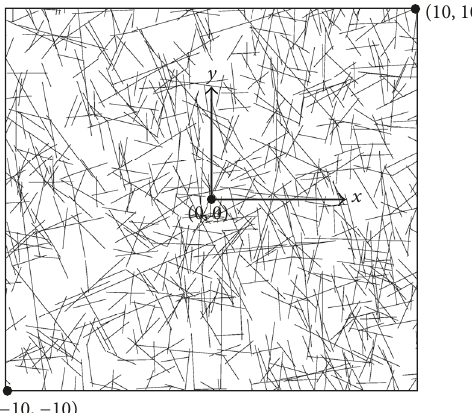
Figure 8: Calculation model studied in the DECOVALEX 2011 project.